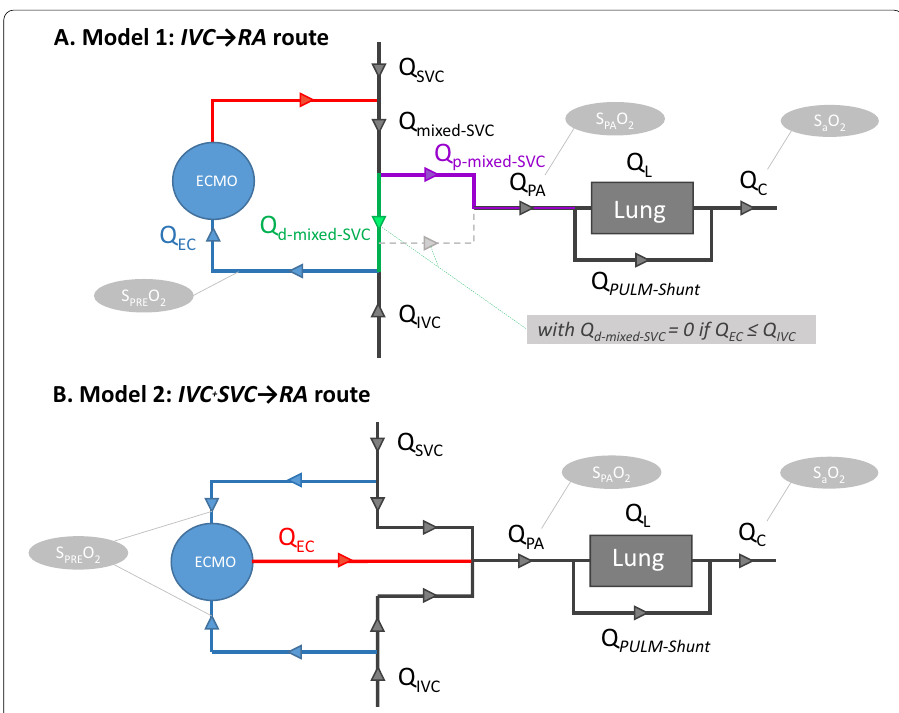
Fig. 1 Modelling of the IVC RA and IVC SVC RA routes. IVC inferior vena cava, RA right atrium, SaO 2 → + → arterial blood oxygen saturation, S PA O 2 pulmonary arterial blood oxygen saturation, S PRE O 2 blood oxygen saturation in the drainage cannula(s), SVC superior vena